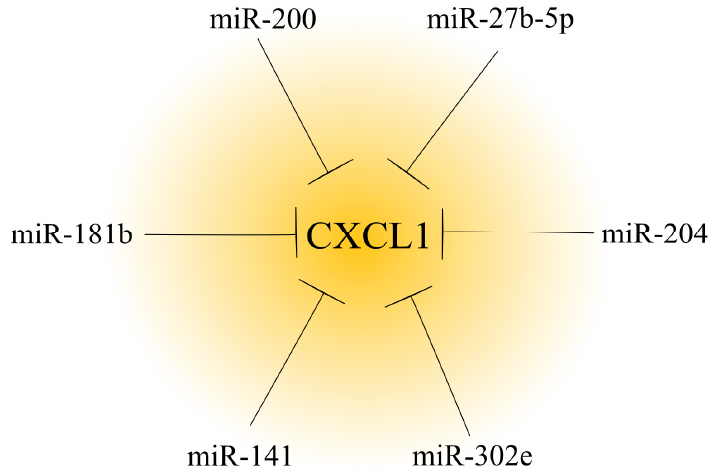
Figure 2. Effect of microRNAs on CXCL1 expression in a tumor. In cancer tumors, CXCL1 expression is regulated by microRNAs. Based on the available literature, six different microRNAs that decrease CXCL1 expression have been identified to